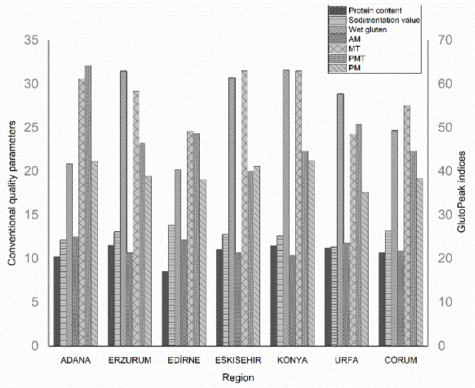
Figure 2. Distribution of average values of whole wheat flour samples due to different